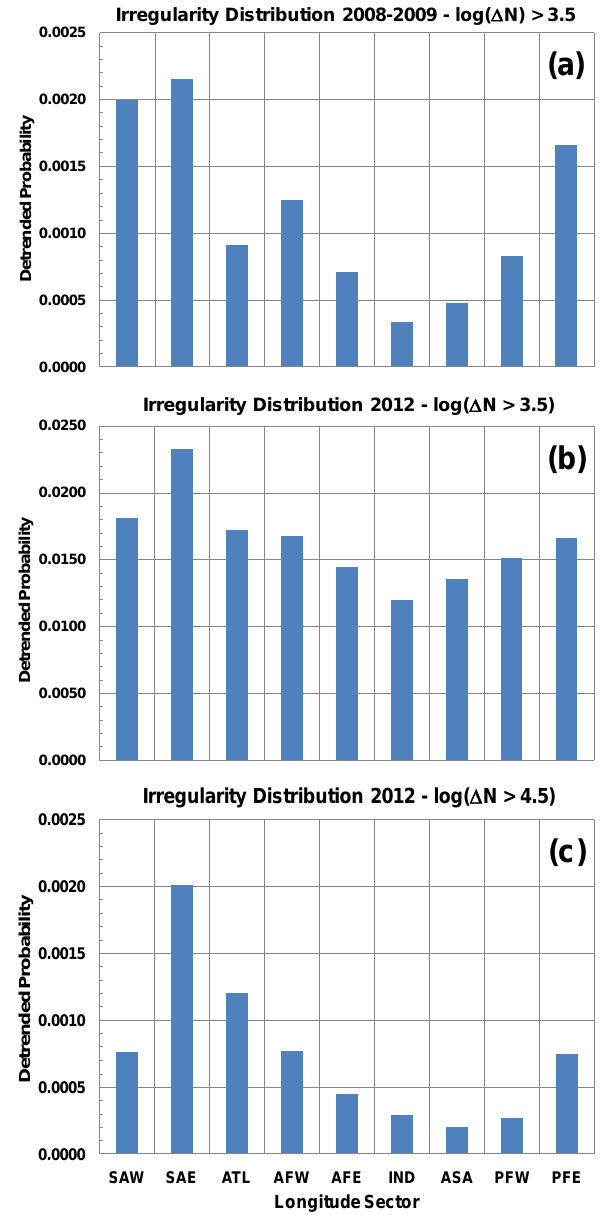
Figure 6. Detrended probability distributions of N i as functions of longitude sectors for: (a) 2008-2009 and log( N i ) > 3.5; (b) 2012 and log( N i ) > 3.5; (c) 2012 and log( N i ) >4.5.